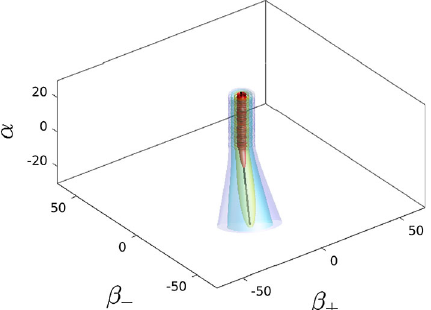
Fig. 3 Plot of the equipotential surfaces of the rescaled wavepacket − 1 / 2 | (cid:2) | for the dust case ( k = 3). The amplitude A + was chosen D ¯ p + , ¯ p − to be a symmetric Gaussian peaked about some momenta ( p + , p − ) = ( ¯ p + , ¯ p − ) , while A − was set to zero. The thin black line is the corre- sponding classical